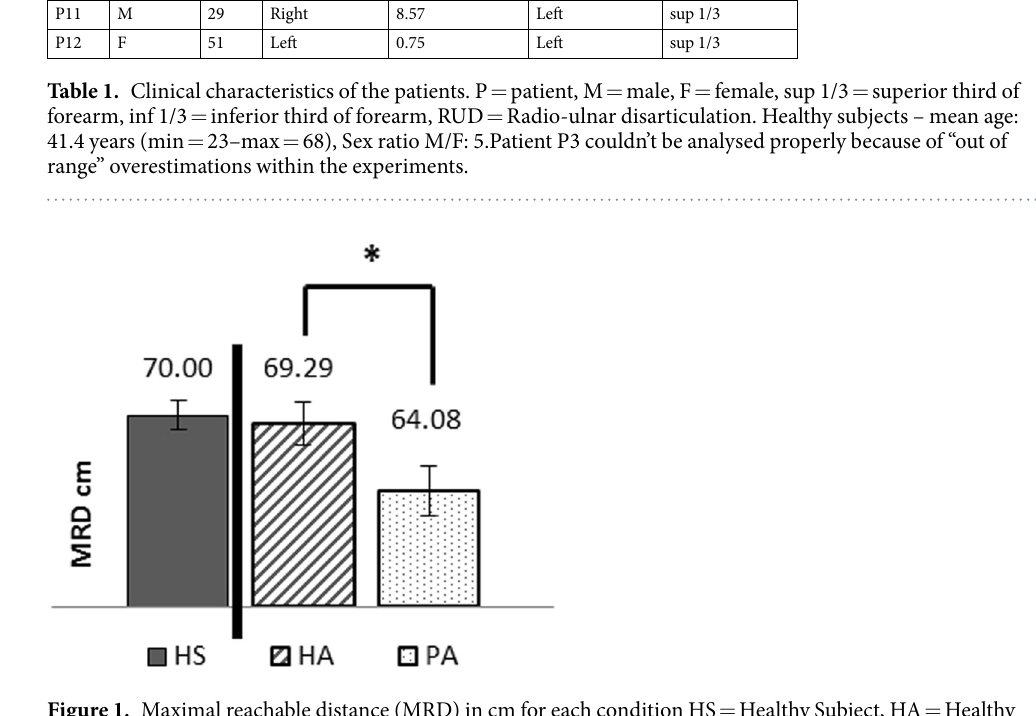
Figure 1. Maximal reachable distance (MRD) in cm for each condition HS = Healthy Subject, HA = Healthy Arm of Amputated Patient, PA = Prosthetic Arm of Amputated Patient * indicate a significant difference between the two groups of participants with p < 0.05